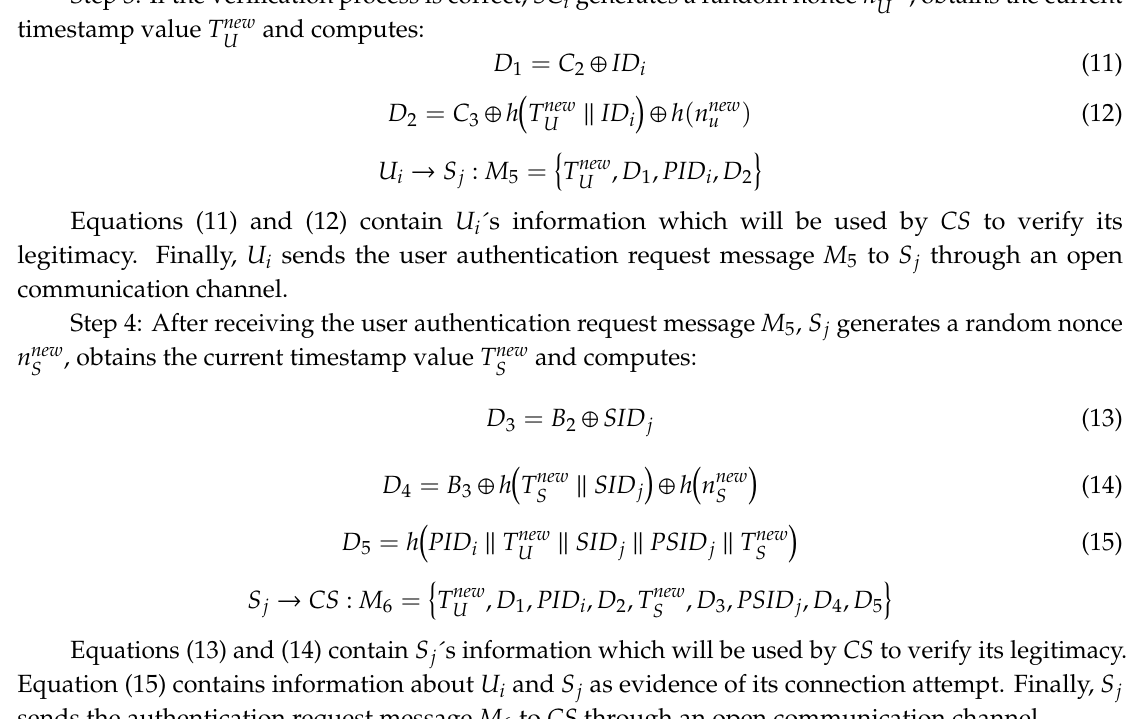
Figure 3. Server registration sub-phase.